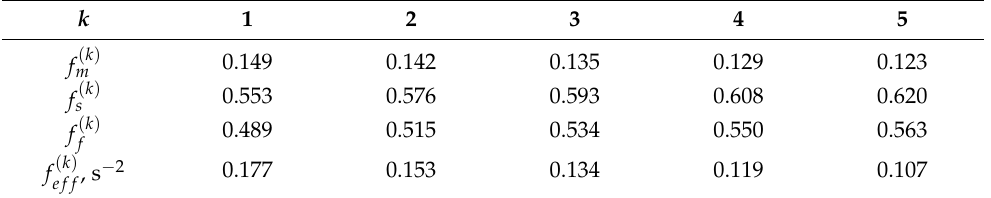
Table 3. Parameters of the braking process